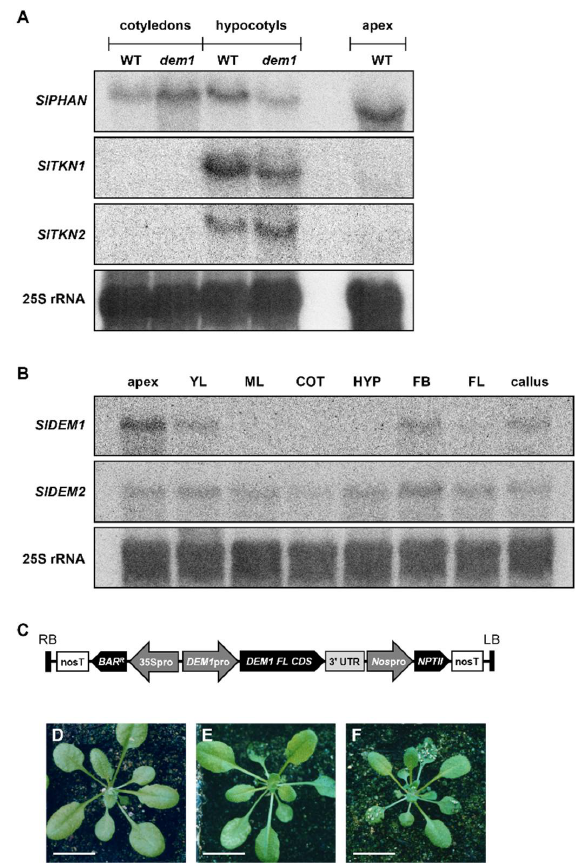
Figure 6. Northern blot hybridization analysis of the transcript abundance of DEM1 and DEM2 and of their potential interactors in WT tomato plants and the dem1 mutant and the transformation of Arabidopsis with SlDEM1 expressing transgenes. ( A ) Northern blot hybridization analysis of the expression of putative SlDEM1 interactors, SlPHAN , SlTKN1 and SlTKN2 , in the cotyledons and hypocotyls of WT tomato plants and the dem1 mutant. ( B ) Construction of the expression profile of SlDEM1 and SlDEM2 in developmentally distinct tissues of WT tomato plants via northern blot hybridization analysis. ( A , B ) Post the initial analysis of the expression of genes of interest, radiolabeled membranes were striped and reanalyzed with a probe specific to the 25S rRNA for use as a loading control. ( C ) Schematic of the DEM1pro : DEM1-FL-CDS transgene for the in planta expression of the full-length CDS and 3 (cid:48) UTR of SlDEM1 gene under the control of the SlDEM1 promoter. Key: RB, T-DNA right border; nosT , nopaline synthase terminator; BAR R , bialaphos resistance gene; 35Spro , CaMV 35S promoter; DEM1pro , DEM1 promoter; DEM1-FL-CDS , full-length DEM1 coding sequence; 3 (cid:48) UTR: DEM1 3 (cid:48) untranslated region; NPTII , neomycin phosphotransferase gene; Nospro , nopaline synthase promoter; LB, T-DNA left border. Wild-type Arabidopsis plants, ecotype Columbia-0 (Col-0) ( D ) were transformed with the DEM1pro : Ex-1 ( E ) or DEMpro : DEM1-FL-CDS ( F ) transgenes. ( D – F )Scale bar = 1.0